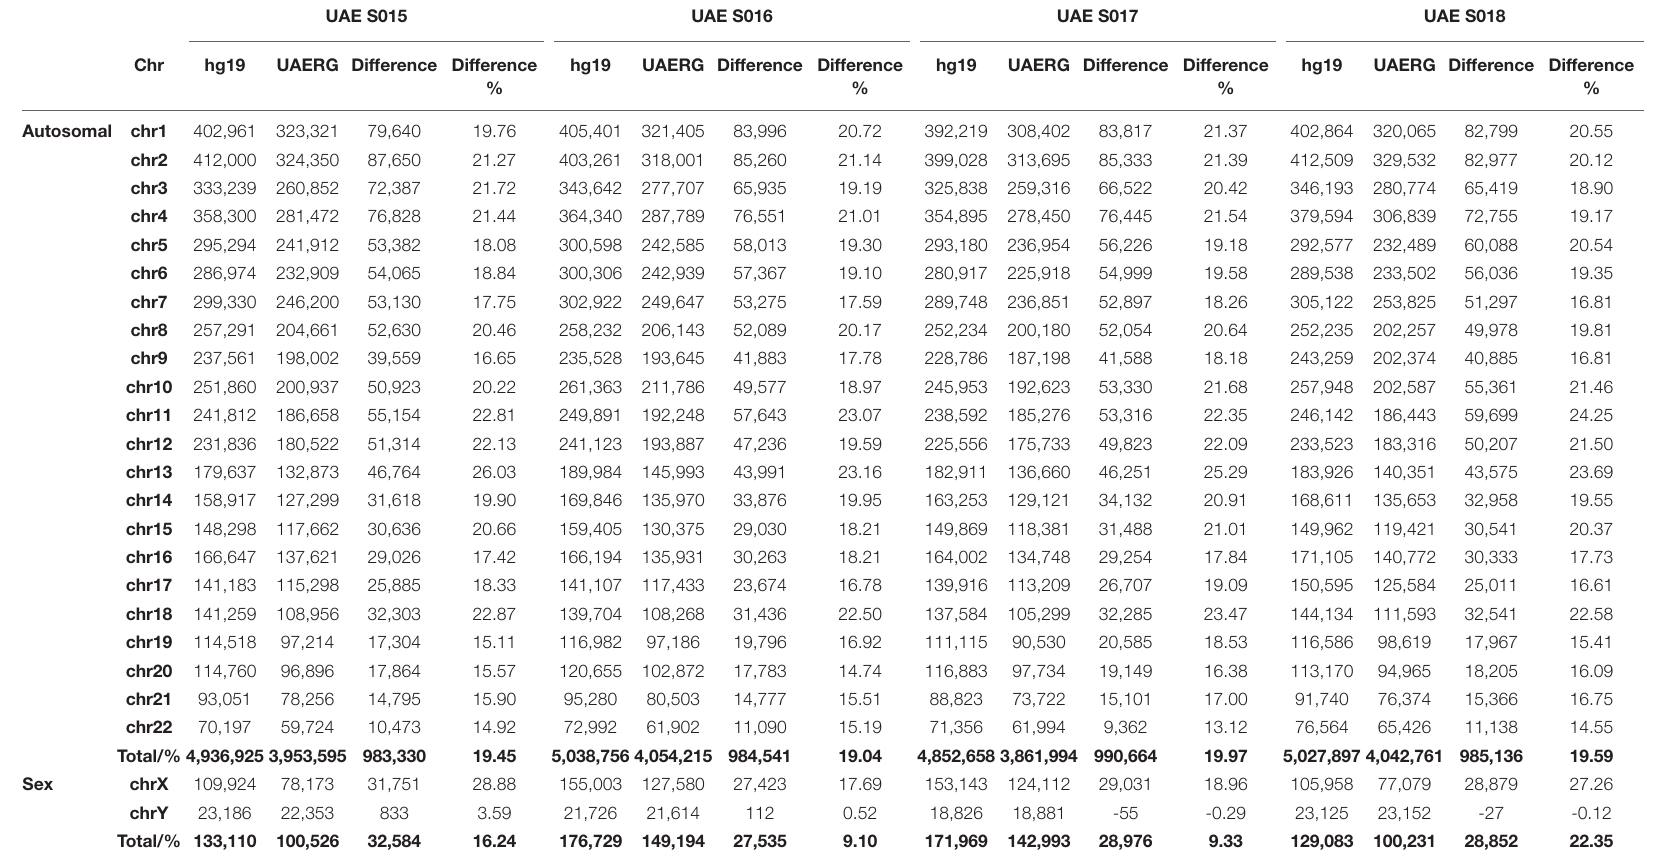
TABLE 3 | Variant call reduction using the UAERG on the sequences from four UAE